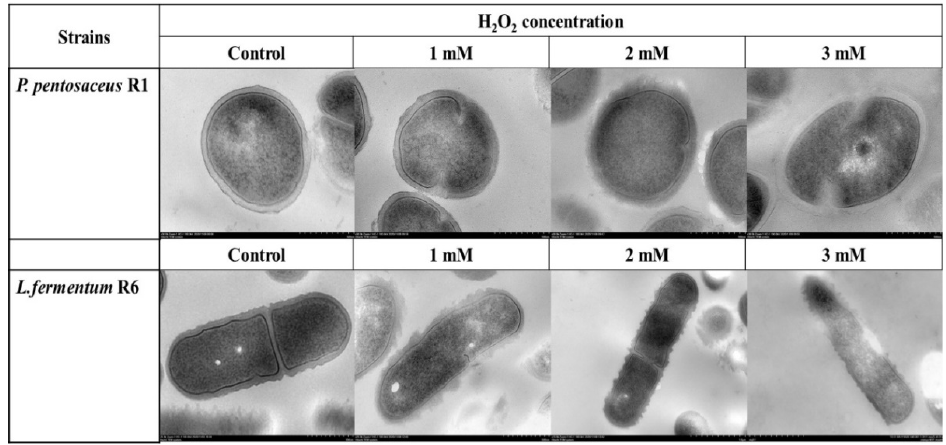
Foods 2021 , 10 , 1203